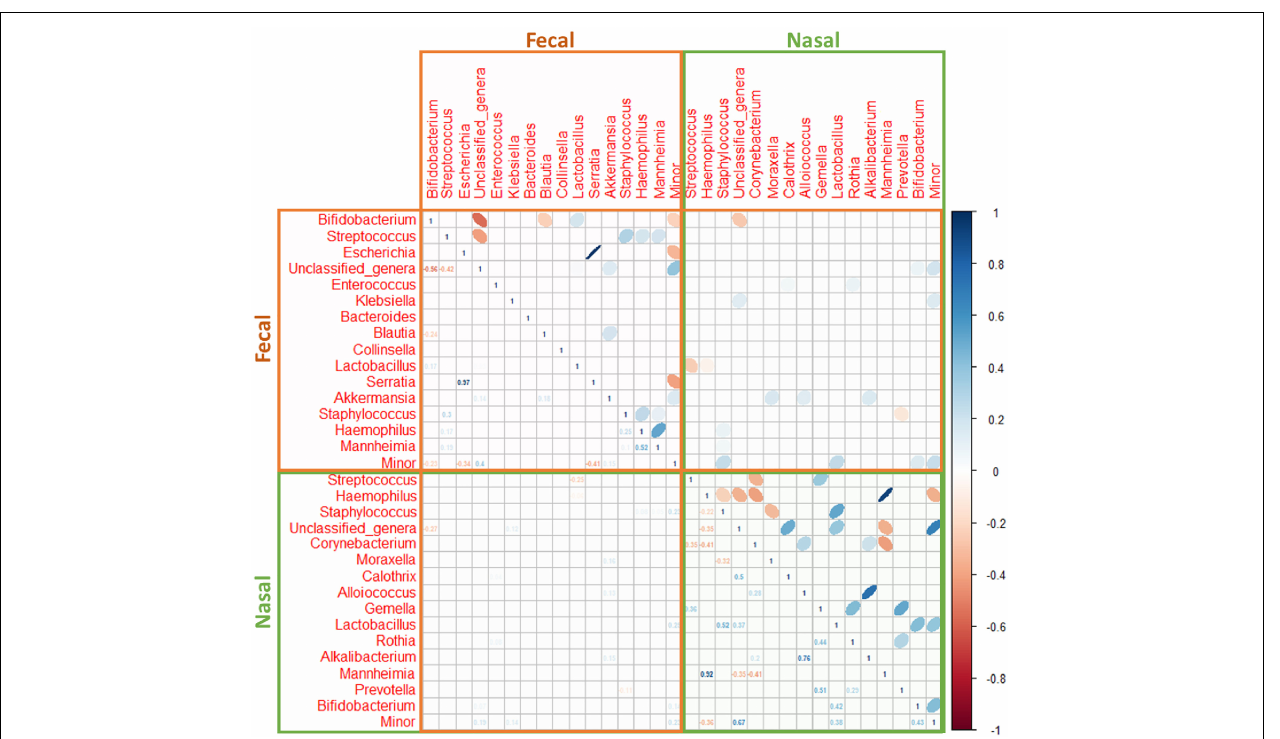
FIGURE 5 | Spearman’s rank correlation analysis of the most abundant bacteria at the genus level in nasal (green box) and fecal (brown box) samples from both control ( n = 9) and bronchiolitis ( n = 34) groups. Blue ellipses represent positive correlations and red ellipses represent negative correlations. Only statistically significant correlations ( p < 0.050) are